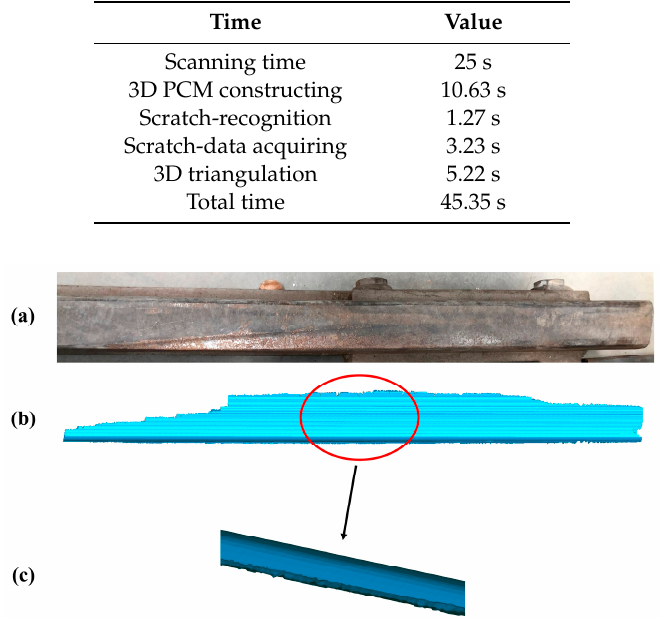
Figure 18. The final complete closed mesh models of the scratch-data of the artificial damaged rail. ( a ) Five complete closed mesh models corresponding to five scratch-data; ( b ) The local magnified model of a − 1 and the full magnified ones of a − 2, a − 3, a − 4, a − 5, respectively. Table 7. The time required in the experiment for the artificial damaged rail.